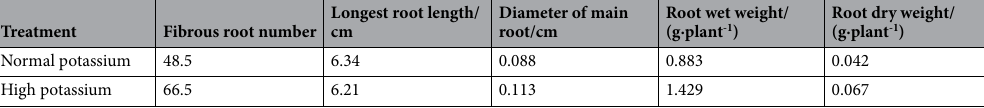
Table 1. Phenotype difference on root of flue-cured tobacco at seedling under two potassium